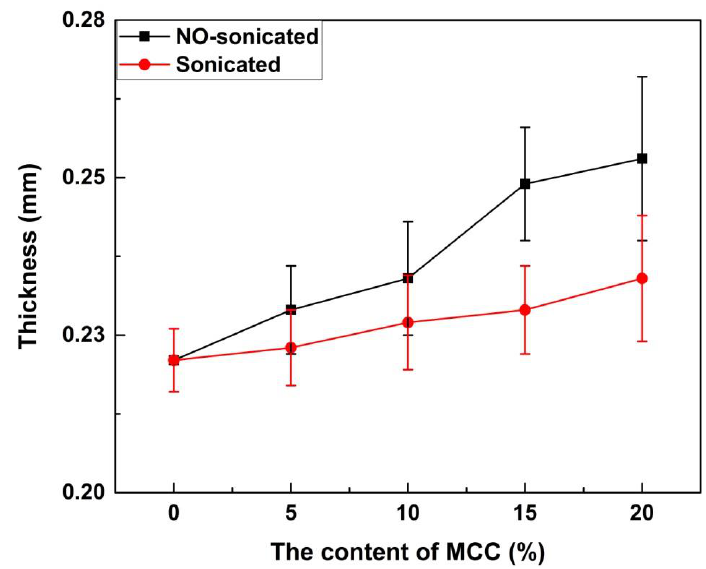
Figure 1. Thickness of microcrystalline cellulose-reinforced fish gelatin (FG/MCC) composite films with and without ultrasonic treatment.